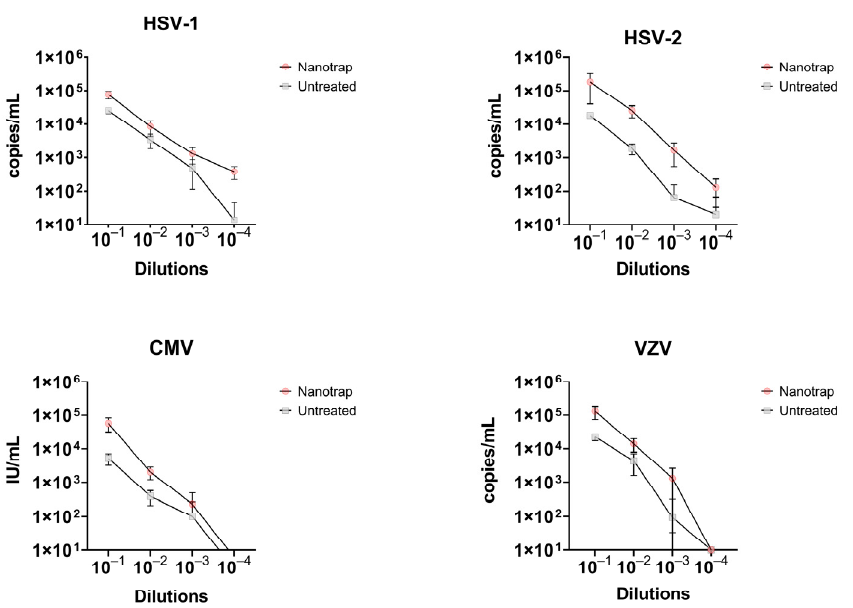
Figure 5. A comparison of samples enriched with Nanotrap Red particles versus those untreated in terms of copy number per mL. Table 2. Mean and standard deviations (in cp/mL), as well as mean Ct value, for both the enriched and non-enriched samples of each pathogen at the 4 concentrations tested (10 4 to 10 1 ).